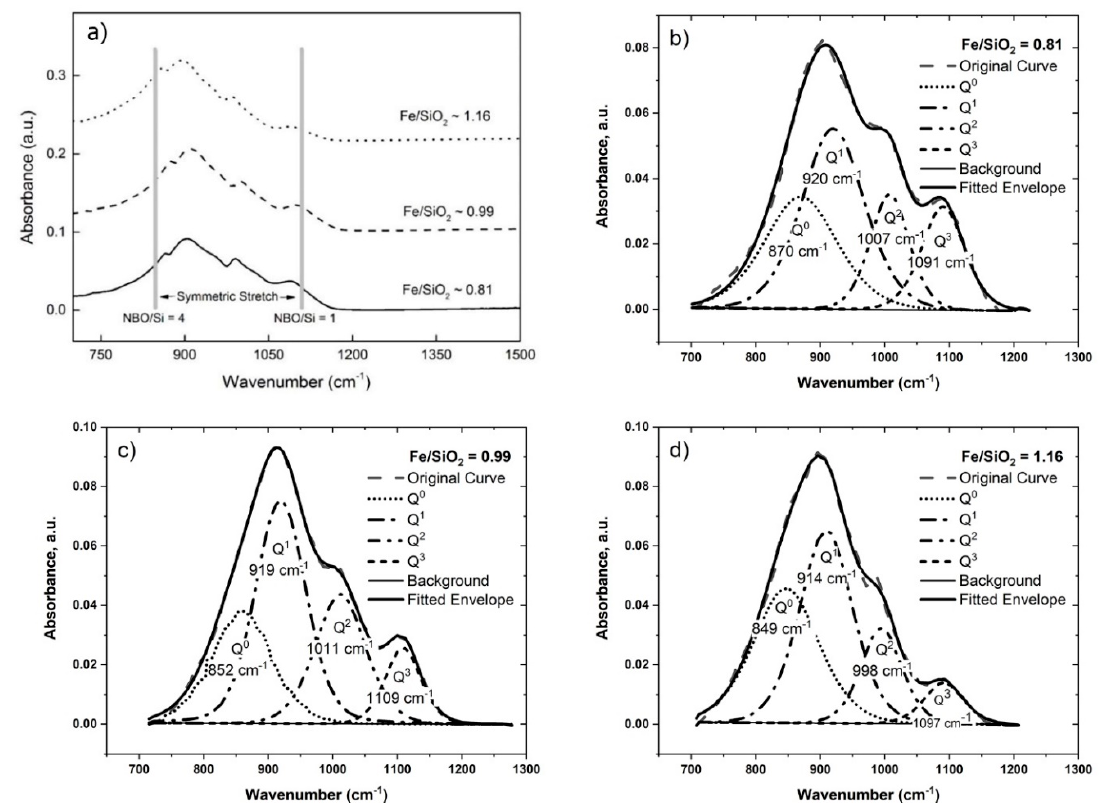
Figure 3. ( a ) FTIR spectra of FCSM slags containing Fe/SiO 2 ratios from 0.81–1.16 ( p O 2 = 10 − 8 atm and T = 1300 °C); and deconvolution results of FTIR spectra for slags with ( b ) Fe/SiO 2 = 0.81, ( c ) Fe/SiO 2 = 0.99 and ( d ) Fe/SiO 2 = 1.16.